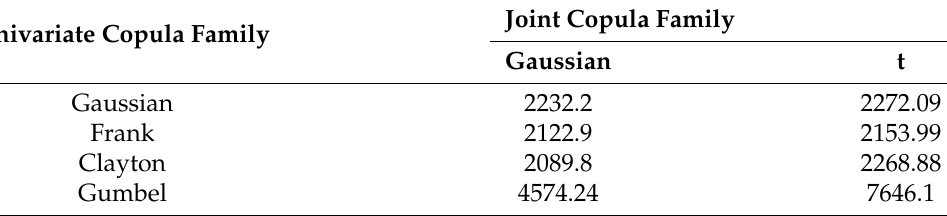
Figure 4. Bar plot and ACFs for sandstorm counts of Rafha ( top ) and Qaisumah ( bottom ). Different copula families were fit for the univariate and joint distributions, and their corresponding AIC values are reported in Table 7. Table 8 represents the parameter estimates and corresponding standard deviations for the fitted bivariate zero-inflated model using the Gaussian copula for the joint and marginal distributions. The standard errors are very small under both the Poisson and ZIP marginals, which emphasizes the robustness of our proposed method. Table 7. AIC values for the BZIP model with different copula